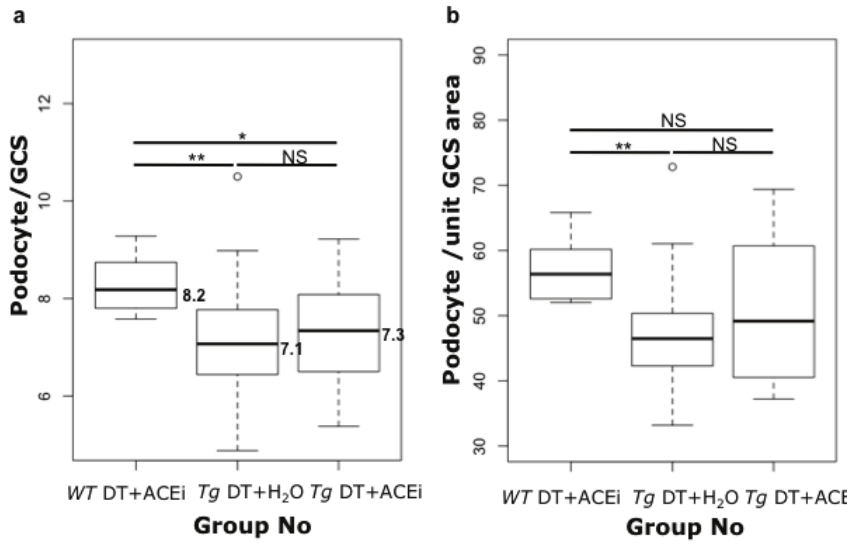
Figure 8. Box plots of the podocyte count ( a ) or podocyte count per unit glomerular cross section area ( b ) for Podo-DTR mice treated with toxin with or without ACEi compared with wild-type (toxin + ACEi treated) mice at week 8. Significance was assessed using the 10% Wilcoxon Rank Sum test. Tg , transgenic; WT , wild-type; ACEi, angiotensin converting enzyme inhibitor; GCS, glomerular cross section; DT, diphtheria toxin; NS, non significant; *, p = 0.03; **, p ≤